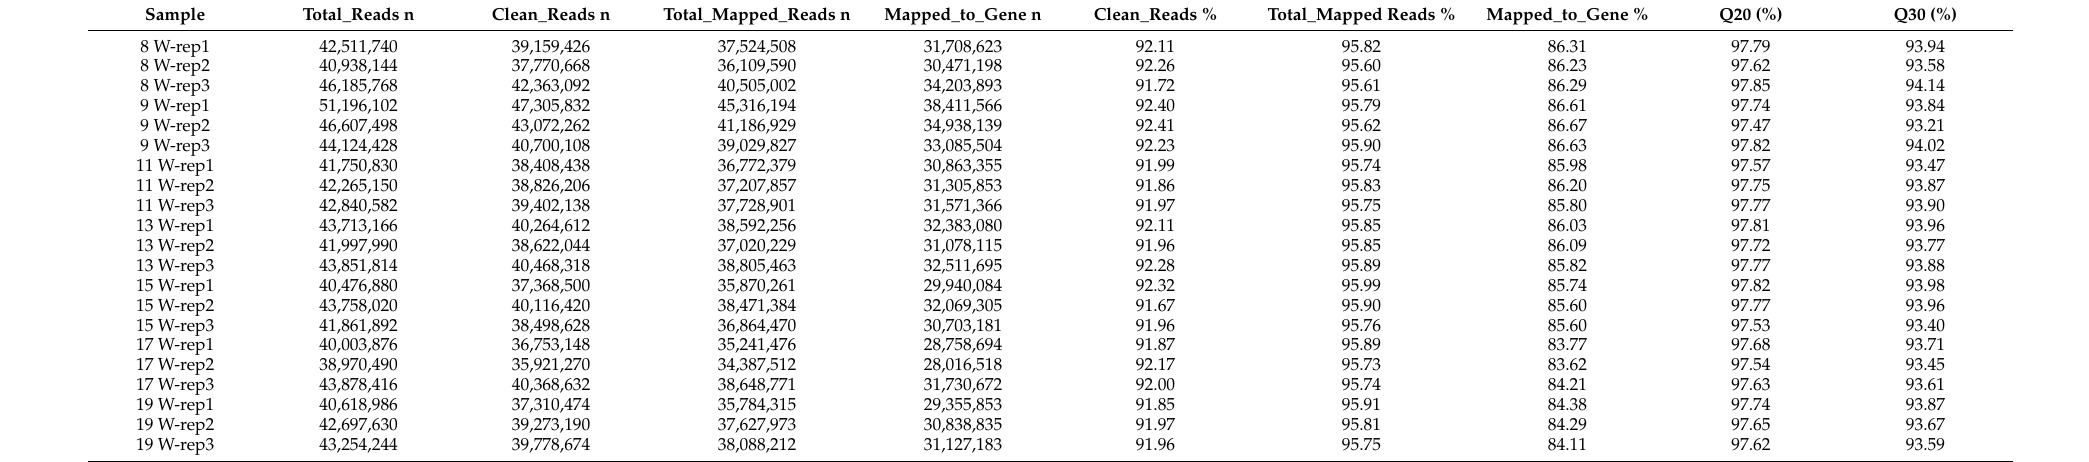
Table 1. Statistics of the RNA-seq profiles in ‘Xinwen179’ at seven different developmental stages.